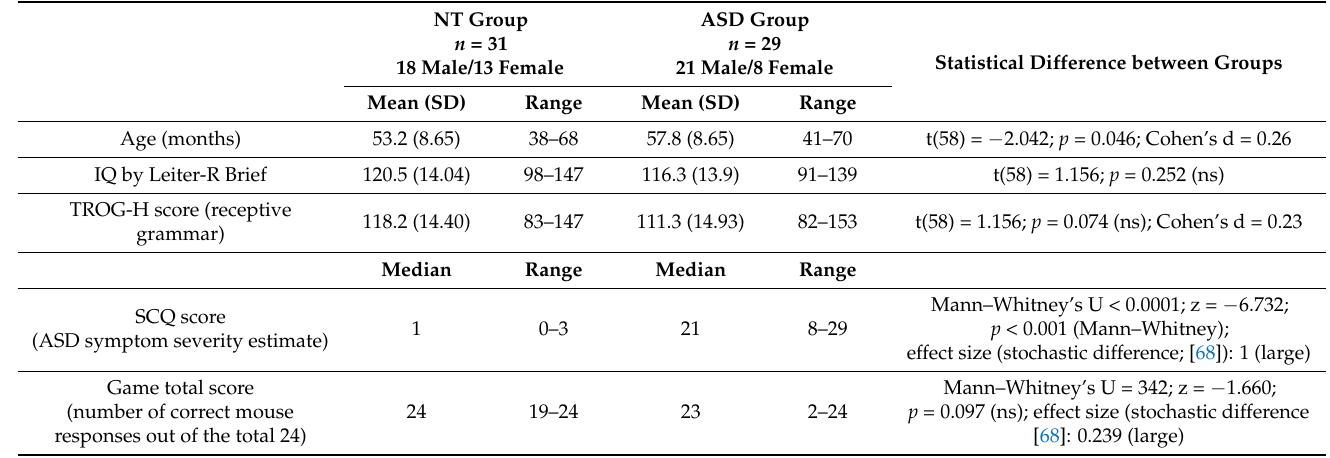
Table 1. Demographic and psychometric characteristics of subjects. At the results of statistical difference between groups “ns” means